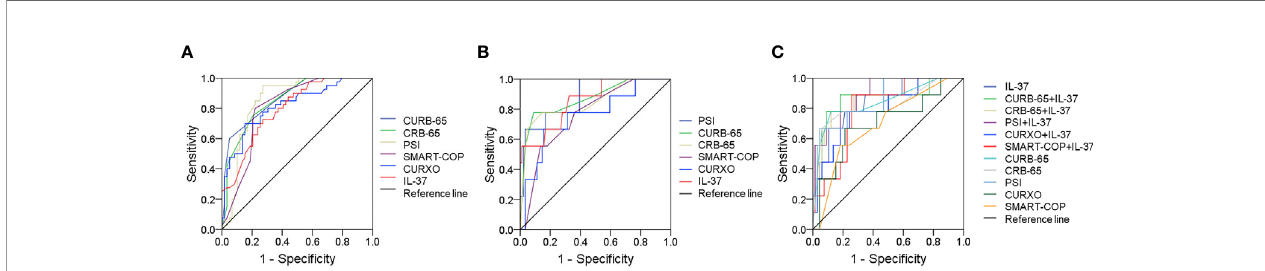
FIGURE 4 | Receiver operating characteristic curves for different predictive biomarkers on admission. (A) ROC curve was used to evaluate the severity of different predictive biomarkers for CAP. (B) ROC curve was used to evaluate the death risk of different predictive biomarkers for CAP. (C) ROC curve was used to evaluate the death risk of serum IL-37 combination with CAP severity